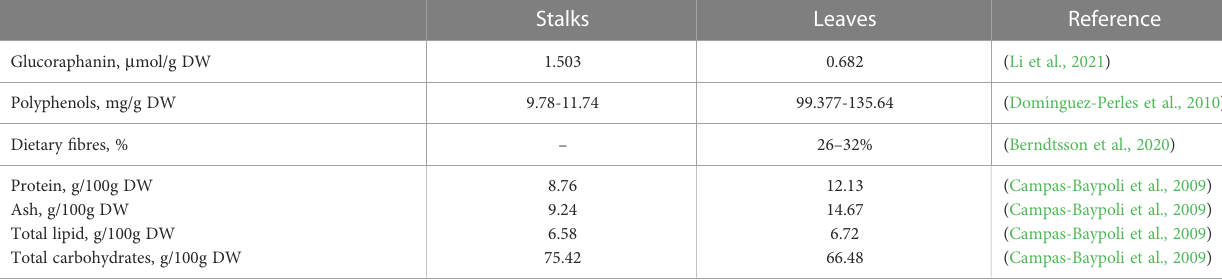
TABLE 1 Content of bioactive substances and nutrient in stalks and leaves of broccoli.